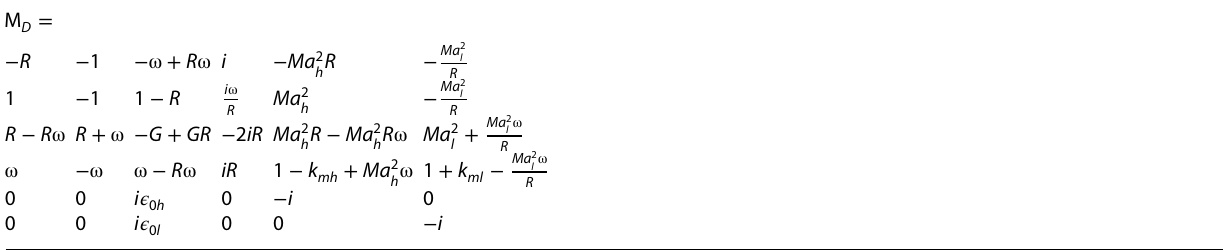
Table 4 The elements of the matrix defining solutions of the interfacial boundary value problem for the diffusion